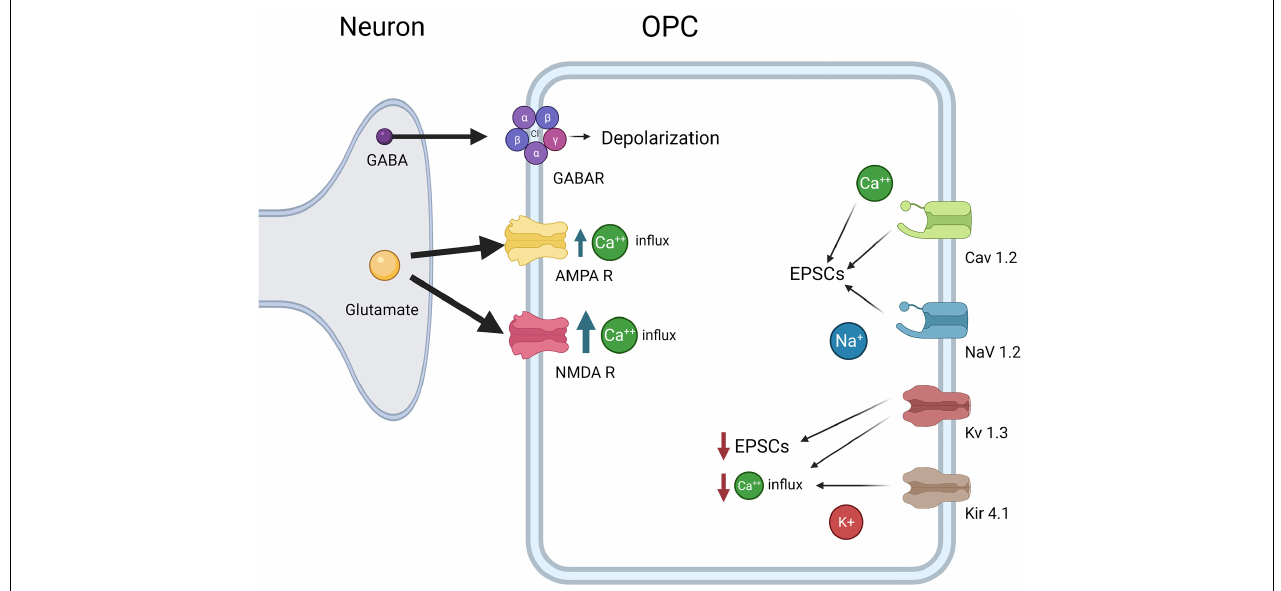
FIGURE 3 | OPC electrophysiological Properties. OPCs express CaV1.2, which results in influx in Ca2+ and increases EPSCs, NaV1.2, which results in influx in Na+ and increases in EPSCs, Kv1.3 which decreases EPSCs and Ca2+ influx, and Kir4.1, which decreases Ca2+ influx. Both glutamate receptors AMPAR and NMDA lead to increased Ca2+ concentrations inside OPCs, although NMDARs allow more Ca2+ influx than AMPARs. Finally, GABAA causes depolarization of the OPCs as the intracellular Cl- concentration is high in